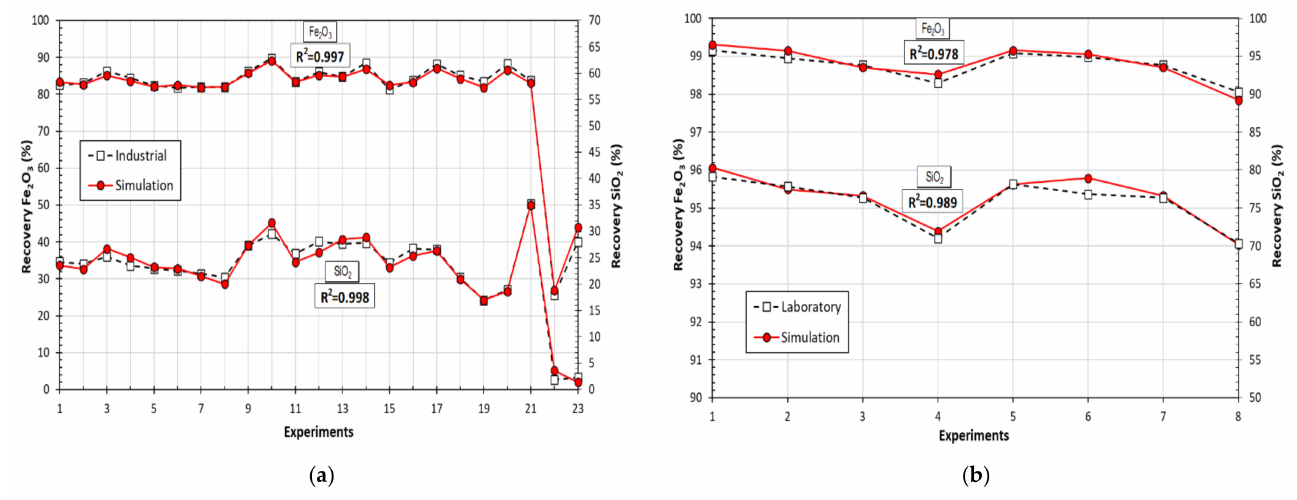
Figure 7. Recovery in underflow: ( a ) for experiments 1 to 23 (industrial) and ( b ) for experiments L1 to L8 (laboratory).